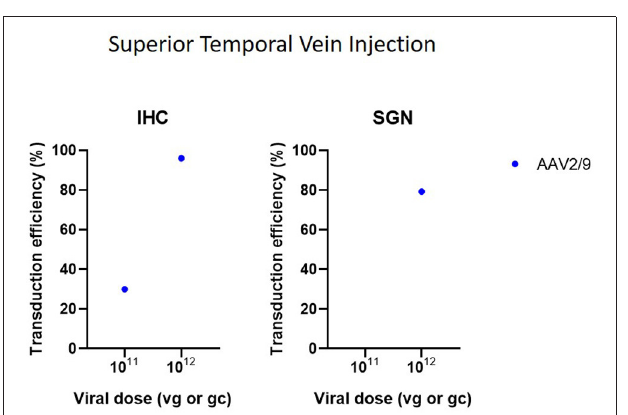
FIGURE 7 | Transduction efficiency of IHC and SGN according to viral vector dose using superior temporal vein injection. Only data from studies that performed inner ear application of AAV in mice were used to plot these graphs. IHC, inner hair cell; SGN, spiral ganglion neuron; AAV, adeno-associated vector; gc, genome copies; vg, viral genomes.